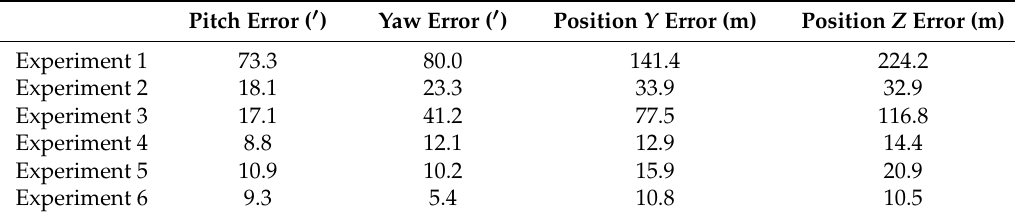
Table 5. Maximum error in position and attitude of different rotation